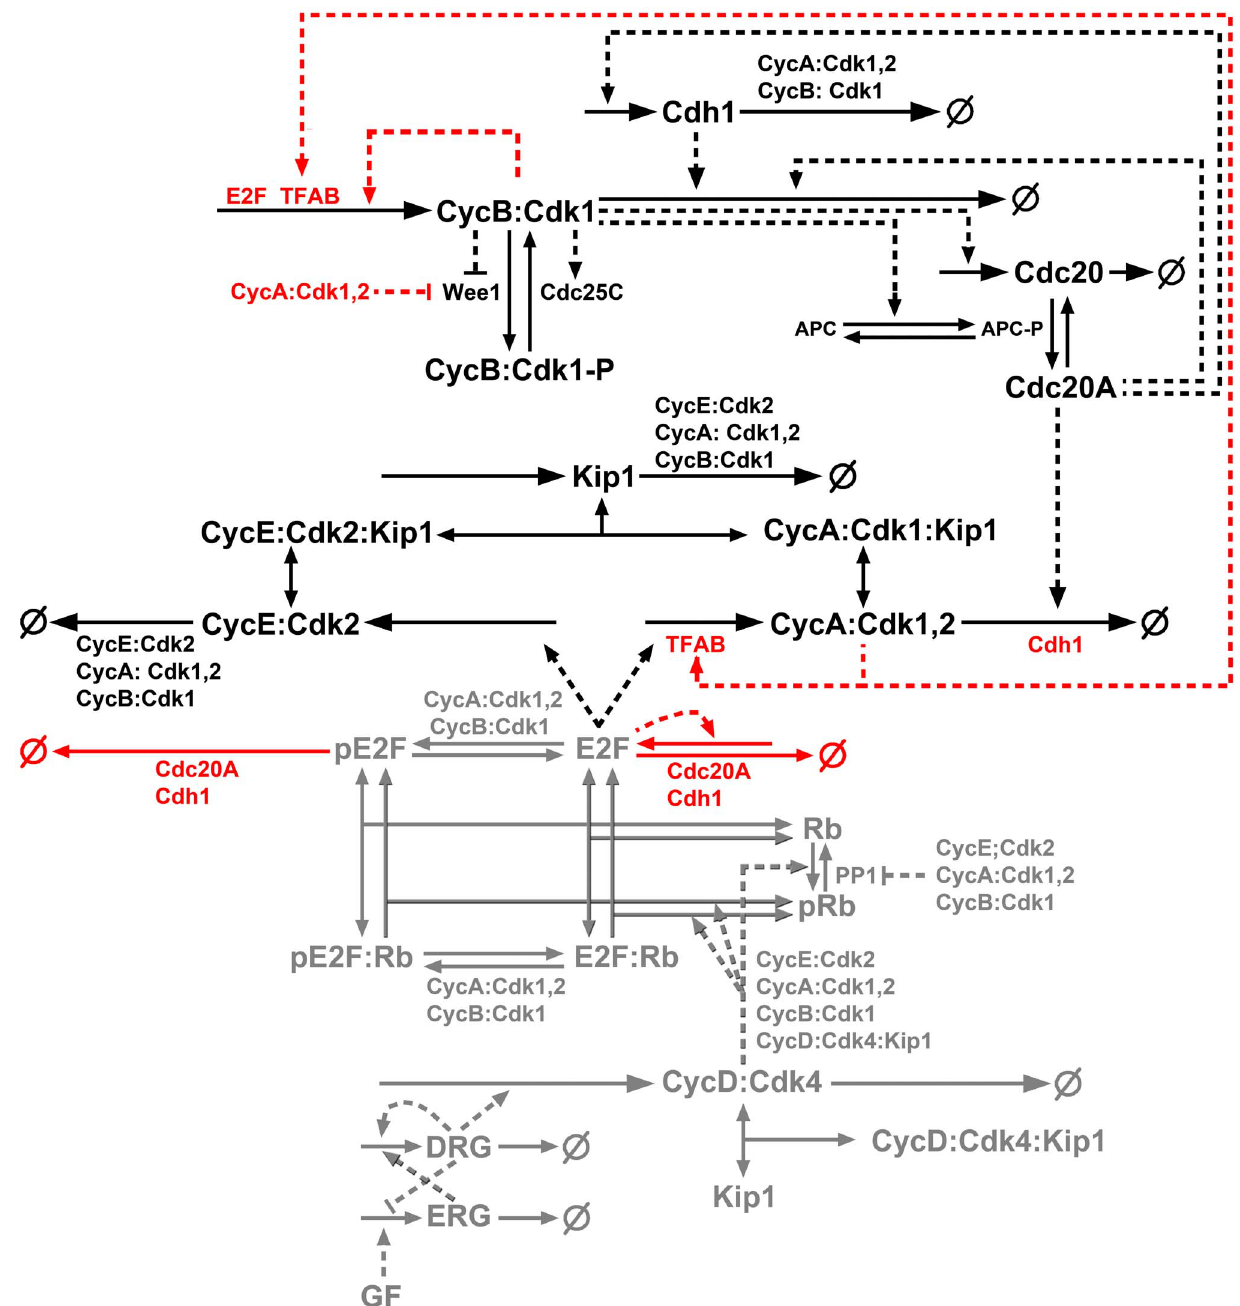
Figure 4. Diagram of a new model. The models presented schematically in Figures 2 and 3 were combined and modifications were introduced to provide better fits to the K562 data. The schematics of the original Csikasz-Nagy model [26] is shown in black, the Conradie model portion [25] is shown in gray, and the new modifications from this study are presented in red. Solid lines indicate chemical reactions and dashed lines regulatory effects. The apparent autocatalytic regulation of cyclin B/Cdk1 synthesis here represents a stabilization of B cyclin synthesis dependent on active cyclin B/Cdk1, whereas the same representation in Figure 2 (Conradie model) represents a Hill equation that is dependent on cyclin B, which is removed here. Thus, the dashed arrow represents a new modification here.